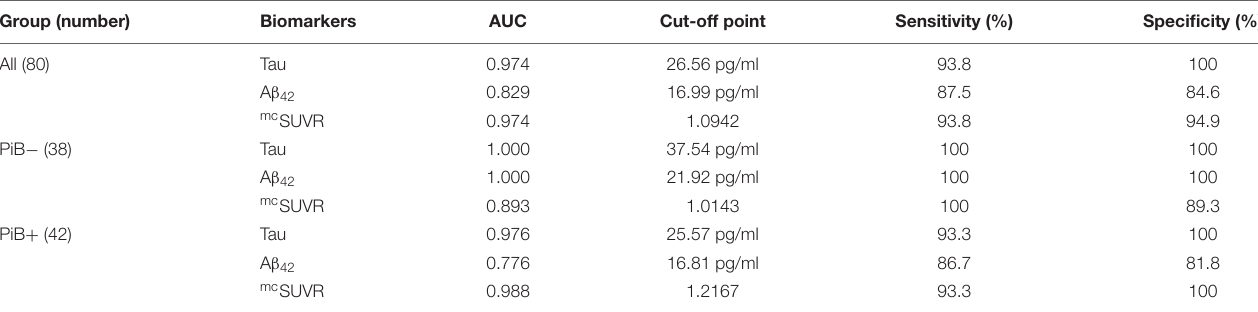
ROC, receiver operating curve analyses differentiating between controls and patients with Alzheimer’s disease; AUC, area under the curve of ROC analysis; PiB + , subjects categorized with positive amyloid deposition; mc SUVR, mean SUVR of all cortical regions.